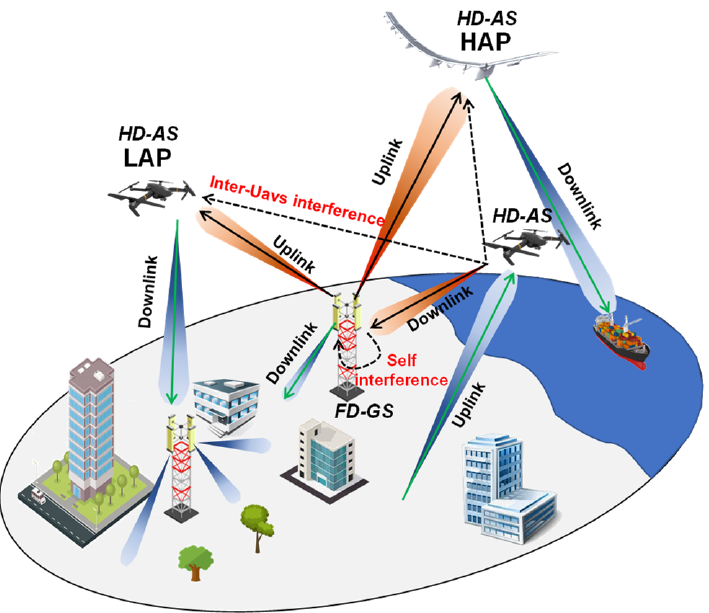
Figure 6. Example of Hybrid-Duplex (HBD) wireless communication.